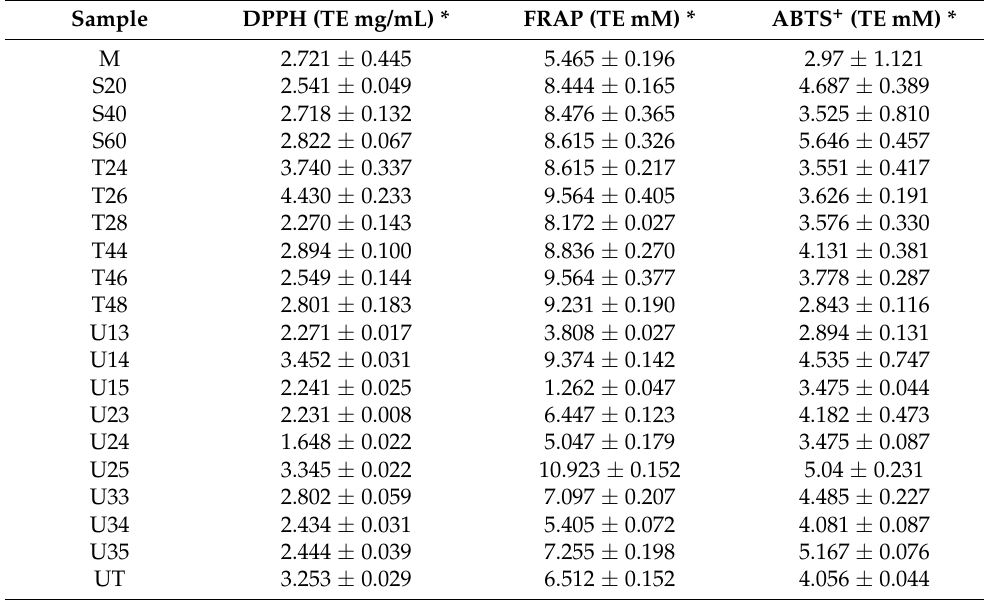
Table 3. Antioxidant capacity of the